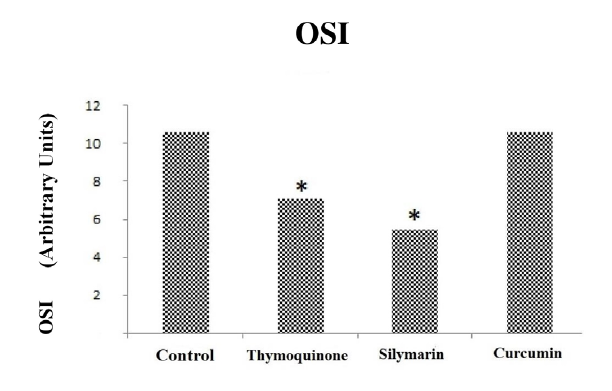
Fig. 3 - Comparison of oxidative stress index (OSI) values between groups. Control = ischemia-reperfusion (I-R) group; Thymoquinone = thymoquinone + I-R group; Silymarin = silymarin + I-R group; Curcumin = curcumin + I-R group. *=statistically